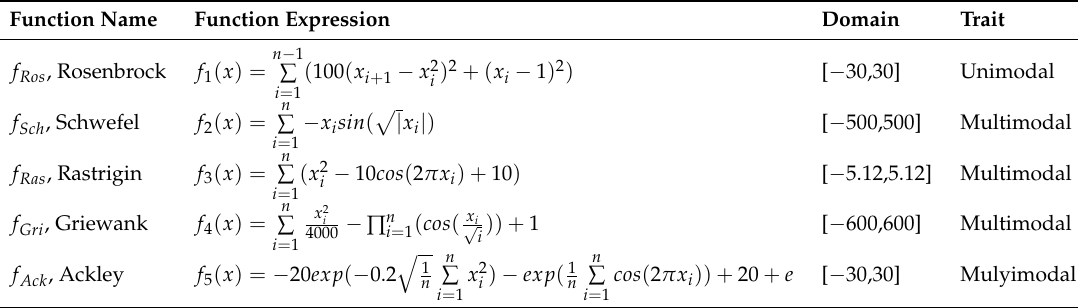
Table 2. Benchmark test functions for validation